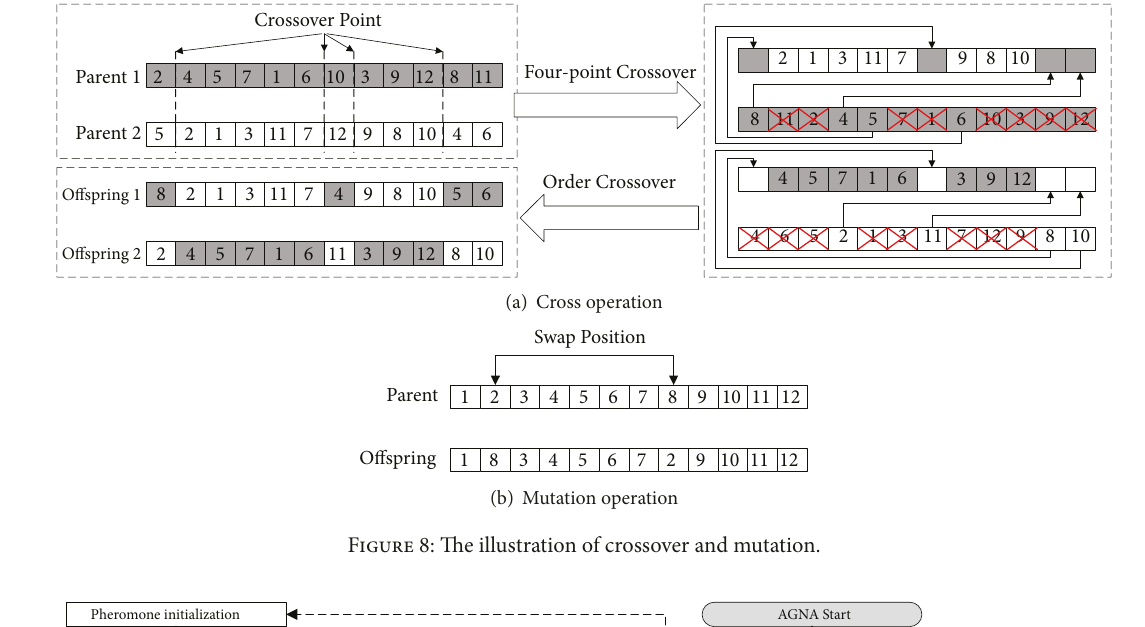
Figure 8: The illustration of crossover and mutation.